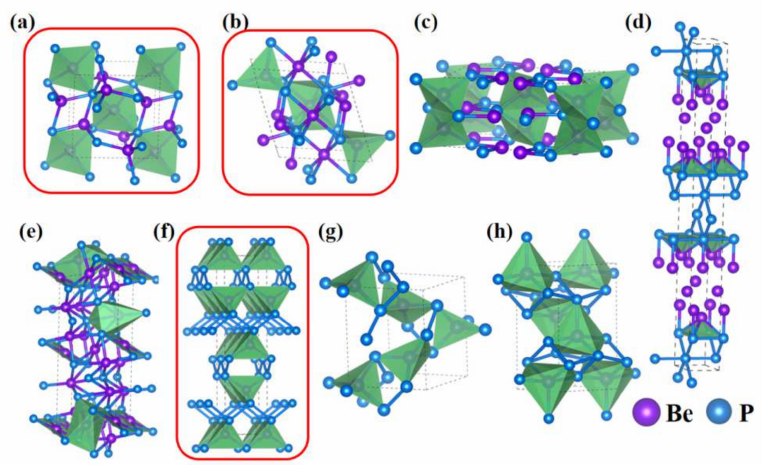
Figure 3. (color online). Crystal structures of the predicted Be − P system for ( a ) Be 3 P 2 − P − 42 1 m , ( b ) Be 3 P 2 − C 2 /m , ( c ) Be 3 P 2 − Ibam , ( d ) Be 3 P 2 − Cmcm , ( e ) Be 3 P 2 − C 2 /m , ( f ) BeP 2 − I 4 1 /amd , ( g ) BeP 2 − P 4 3 2 1 2, and ( h ) BeP 2 − Imma . Be atoms and P atoms are represented by the purple and blue spheres, respectively. Inside the red circular region, the structures are